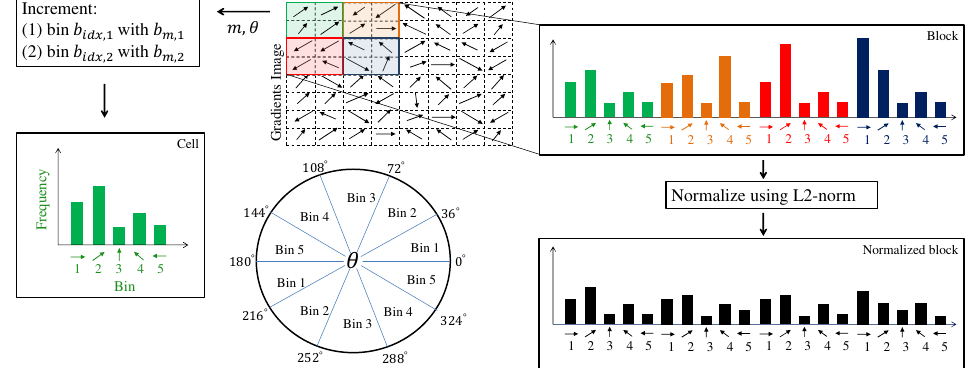
Figure 3. Demonstration example of HOG cell and block calculation. The colors of each histogram are to refer to its respective cell. The number below each bar is to indicate the bin index in the histogram. In this example, Q bins is equal to